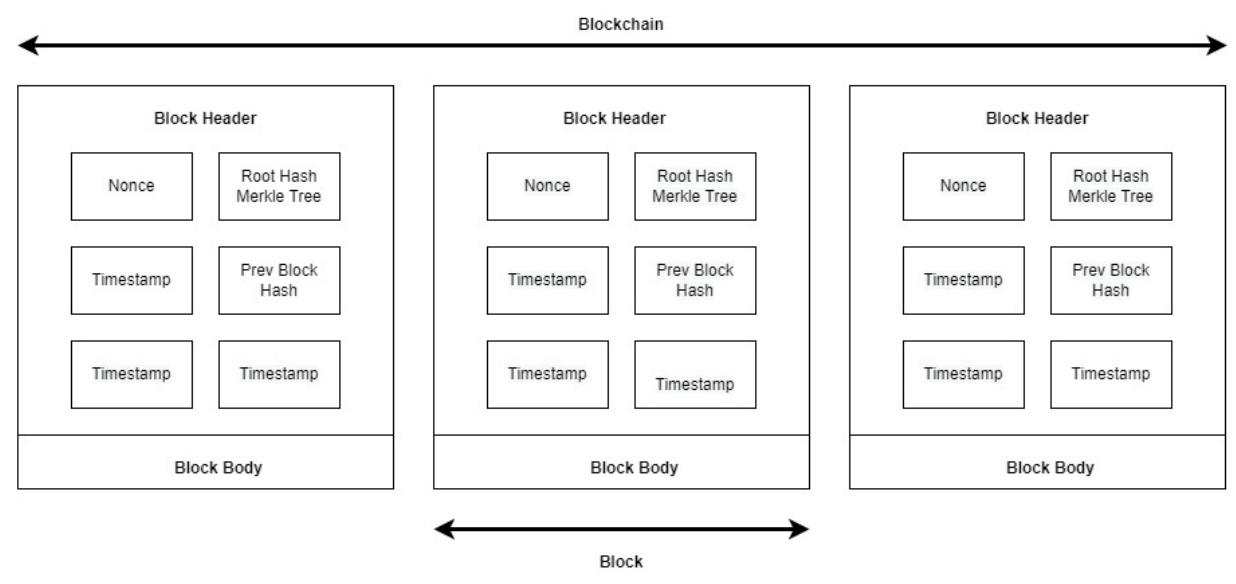
Figure 1. The structure of a blockchain.